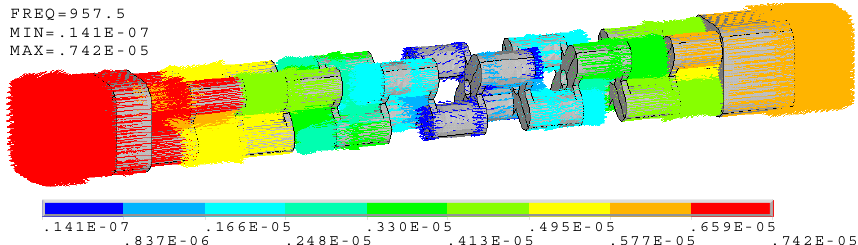
Figure 4. Vector illustration of vibration at 957.5 Hz (cascade-connected transducer with twelve segments).